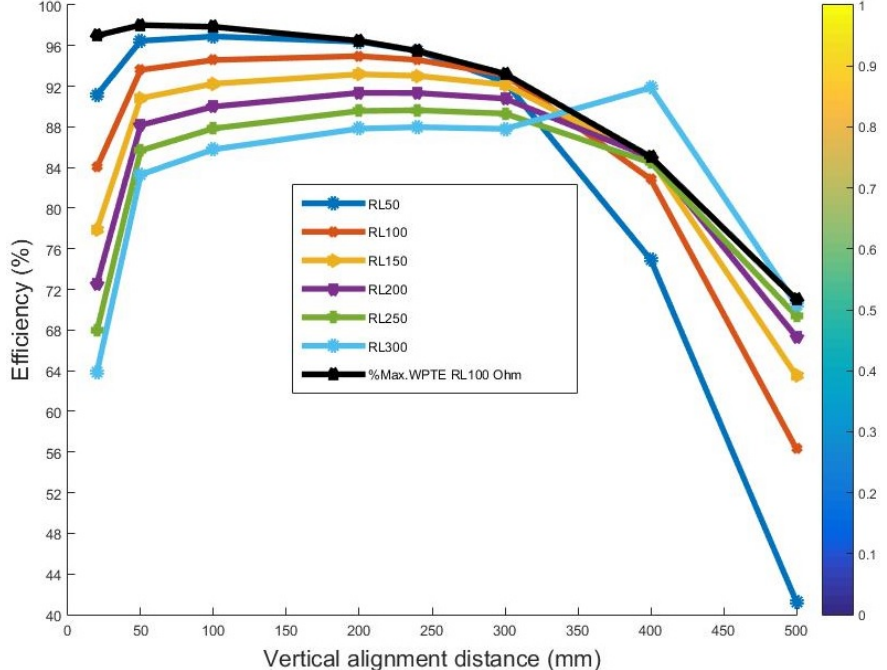
Figure 13. Comparison of different R L values in simulation of vertical alignment between STLAC and MTSCC lumped parameter performances of efficiency at different R L values and different distances with Max.WPTE. in mm.